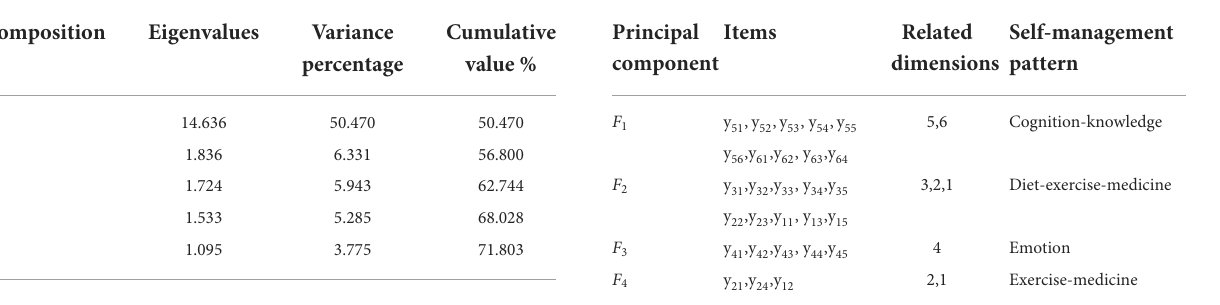
TABLE 4 Initial eigenvalues and variance.